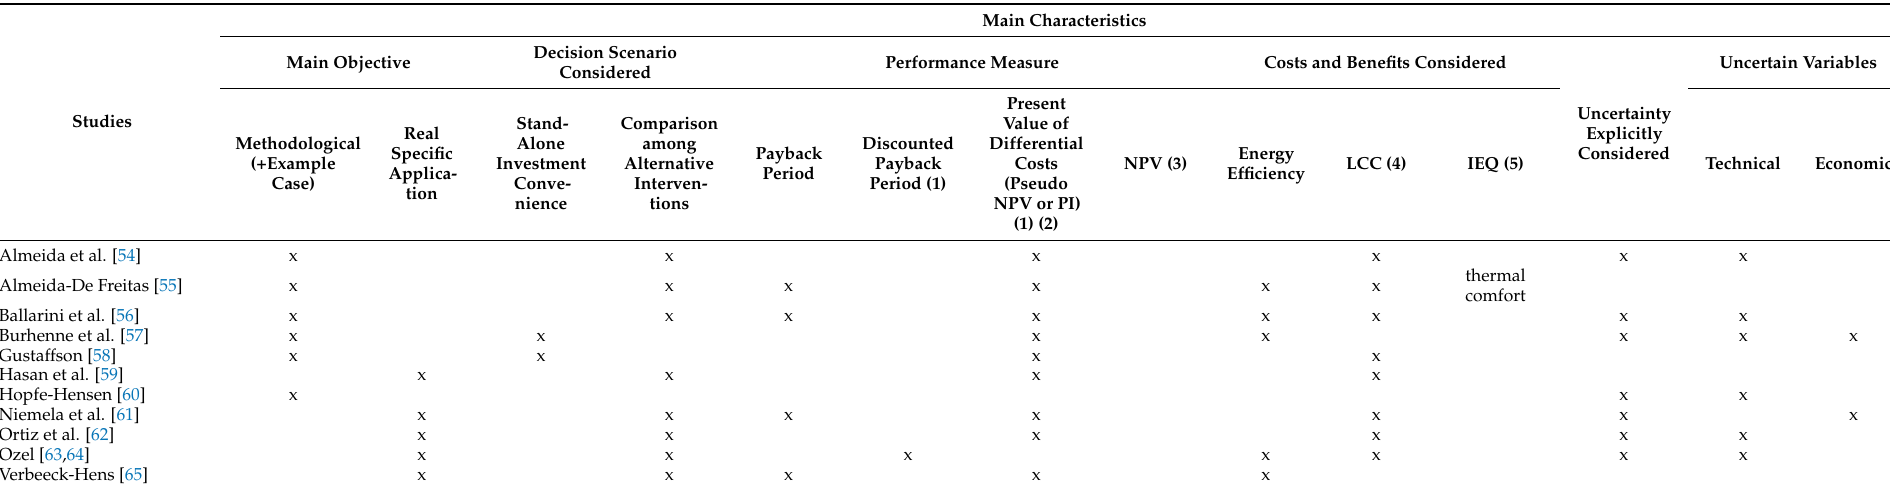
Table 5. Studies on the Economic Convenience of a Retrofit